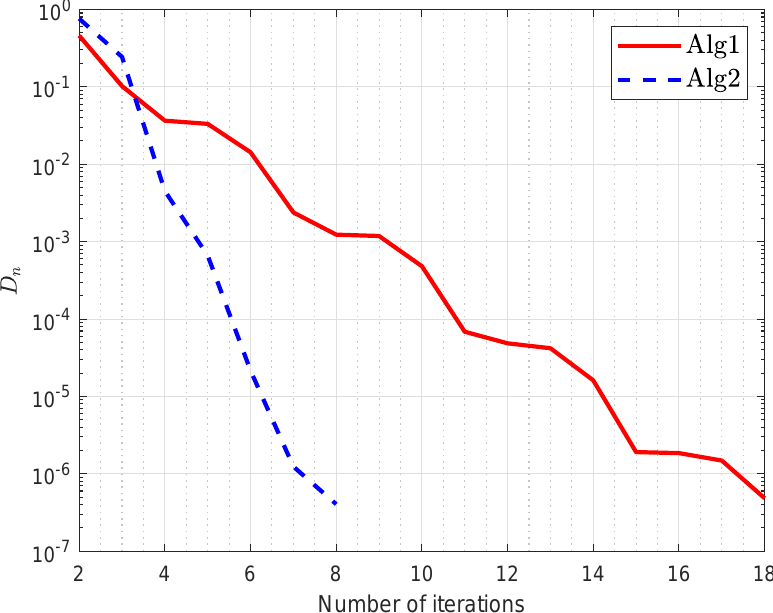
Figure 2. Example 4: Algorithm 1’s numerical comparison with Algorithm 1 in [19] by letting u − 1 = u 0 = ( 2.5,3.5 )